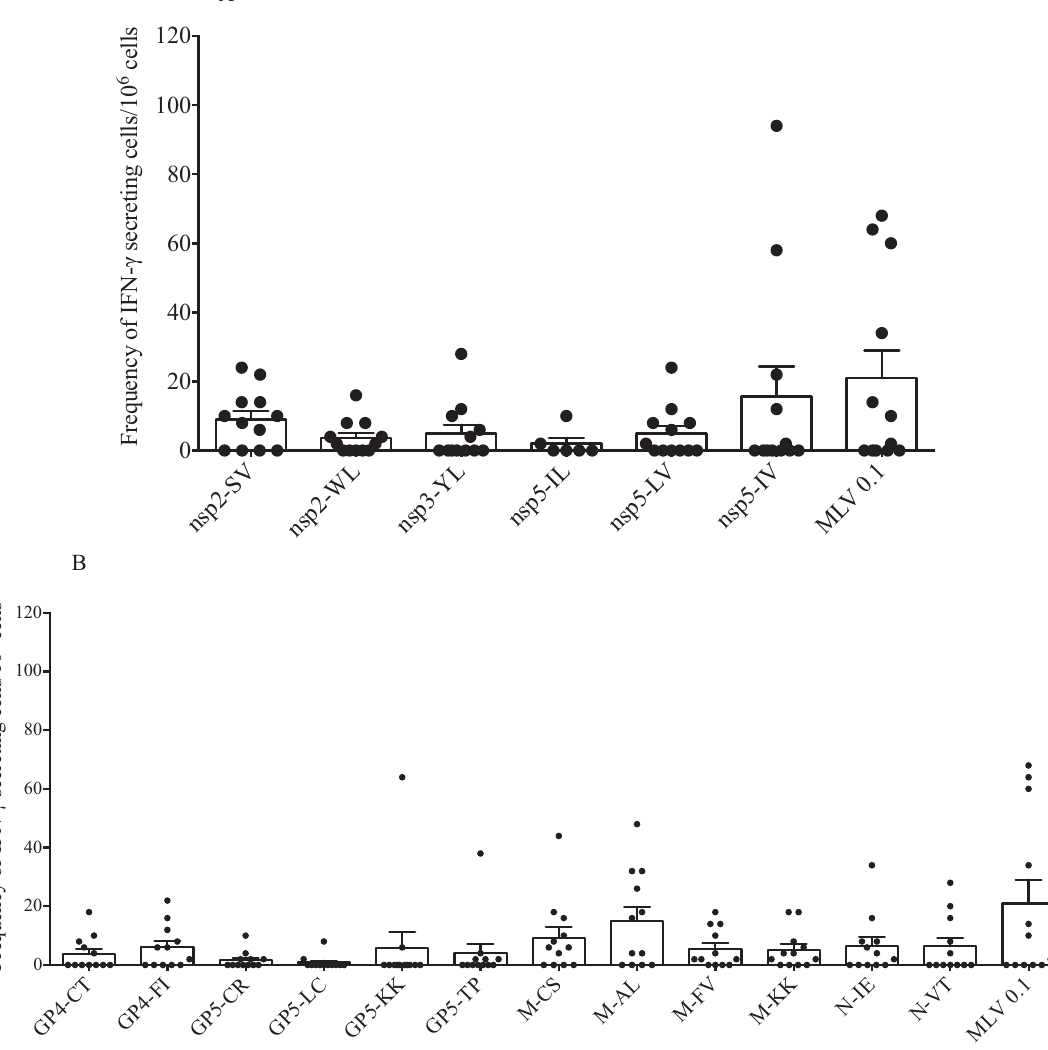
Figure 4. Cellular response against IFN-(cid:2) inducer peptides of both individual nsp and structural proteins by multiparous and hyper-vaccinated sows. IFN(cid:2)-SC frequencies of multiparous and hyper-immunized sows were evaluated by stimulating PMBCs of multiparous sows with IFN-(cid:2) inducer peptides from nsp ( A ) and structural proteins ( B ) of PRRSV. No statistical significance was observed in the IFN(cid:2)-SC frequency between sow groups. Each bar represents the mean of twelve sows ± standard